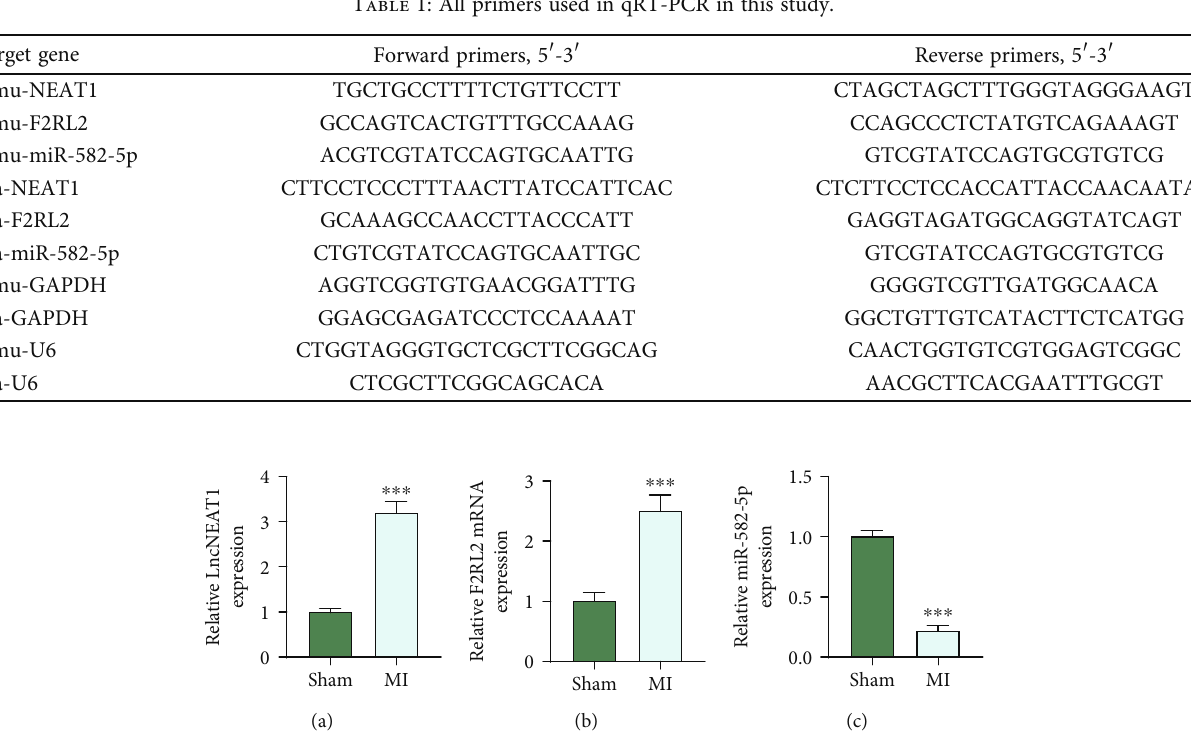
Figure 1: NEAT1 and F2RL2 were highly expressed while miR-582-5p was lowly expressed in MI mice. (a – c) The expressions of NEAT1, F2RL2, and miR-582-5p in myocardial tissues of MI mice were examined by qRT-PCR. ( ∗∗∗ P < 0 : 001 , vs. sham) (NEAT1: nuclear paraspeckle assembly transcript 1; F2RL2: coagulation factor II thrombin receptor like 2; qRT-PCR: quantitative RT-PCR; MI: myocardial